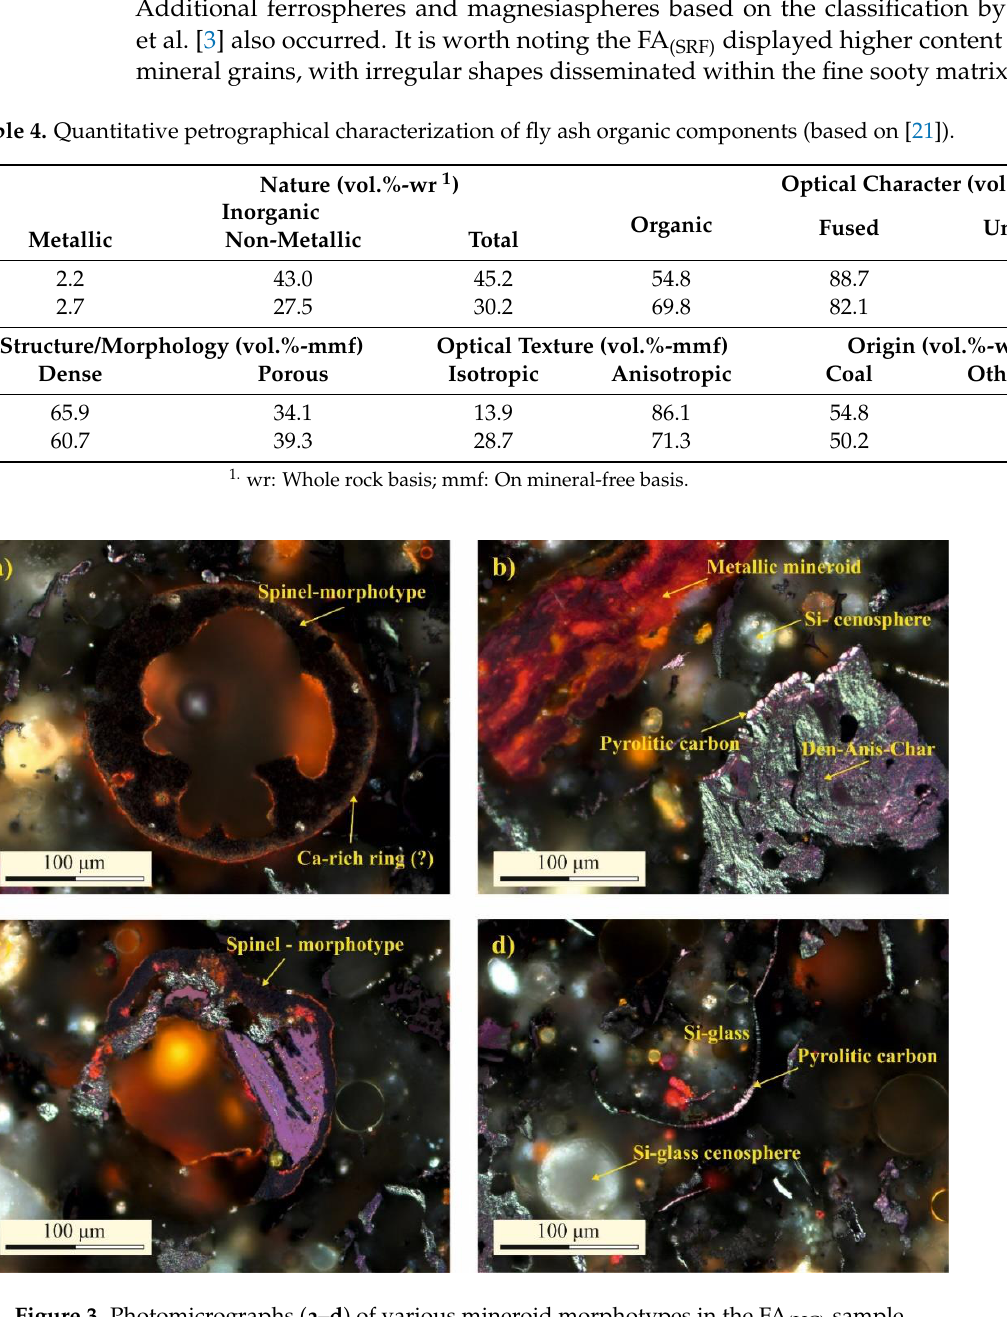
Figure 3. Photomicrographs ( a – d ) of various mineroid morphotypes in the FA (HC)